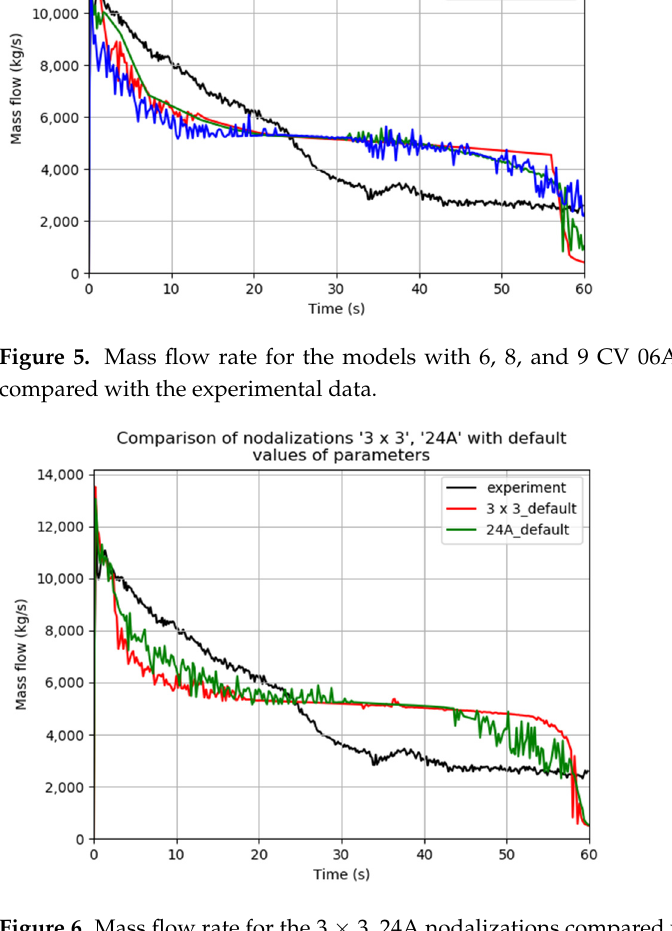
the experimental data.